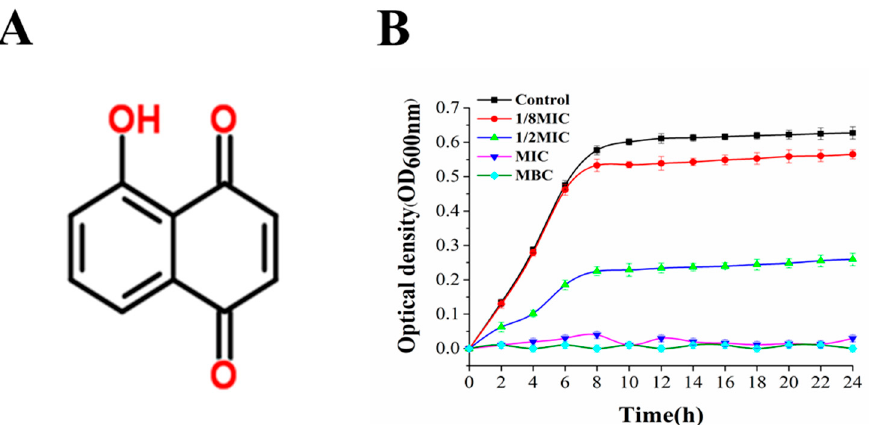
Figure 2. ( A ) Chemical structure formula of juglone; ( B ) growth curve of P. aeruginosa exposed to juglone. Table 2. Diameter of inhibition zone, minimum inhibitory concentration (MIC), and minimum bactericidal concentration (MBC).